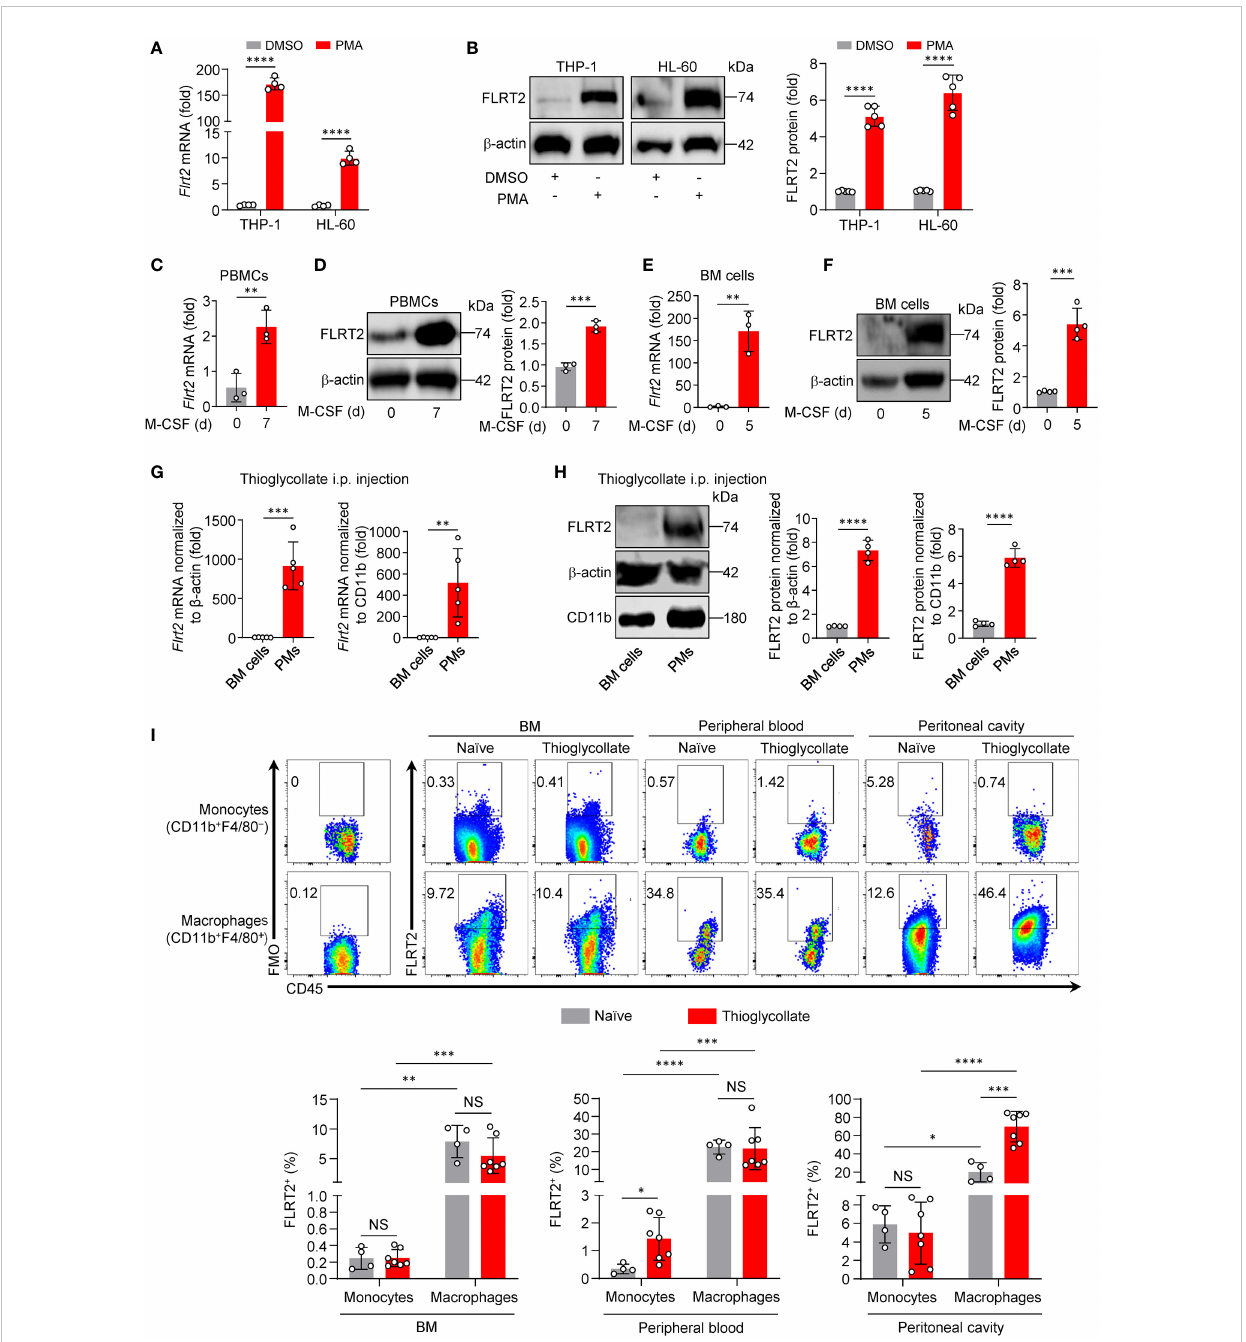
FIGURE 1 FLRT2 is signi fi cantly induced during monocyte-to-macrophage differentiation in vitro and in vivo . (A, B) THP-1 or HL-60 cells were treated with DMSO or PMA (100 ng/ml) for 24 h. FLRT2 mRNA and protein levels were detected by qPCR ( A , n = 4) and immunoblot ( B , n = 5) analyses, respectively. (C, D) qPCR analysis of Flrt2 mRNA ( C , n = 3) and immunoblot analysis of FLRT2 protein ( D , n = 3) in human PBMCs induced by M-CSF (40 ng/ml) for 0 or 7 days. (E, F) qPCR analysis of Flrt2 mRNA ( E , n = 3) and immunoblot analysis of FLRT2 protein ( F , n = 4) in bone marrow (BM) cells induced by M-CSF (25 ng/ml) for 0 or 5 days. (G, H) qPCR analysis of Flrt2 mRNA ( G , n = 5 mice per group) and immunoblot analysis of FLRT2 protein ( H , n = 4 mice per group) in BM cells and peritoneal macrophages (PMs) isolated from C57BL/6J mice after intraperitoneal (i.p.) thioglycollate injection. mRNA and protein levels were normalized to both b -actin and CD11b. (I) Representative fl ow cytometric pro fi les and data plots showing the frequencies of FLRT2 + CD45 + CD11b + F4/80 − monocytes and FLRT2 + CD45 + CD11b + F4/80 + macrophages in the BM, peripheral blood, and peritoneal cavity of C57BL/6J mice injected i.p. with or without thioglycollate for 3 days (n = 4 or 7 mice per group). Data are means ± SD. P values were determined using unpaired, two-tailed Student ’ s t -tests. NS, not signi fi cant. * P < 0.05, ** P < 0.01, *** P < 0.001, **** P <